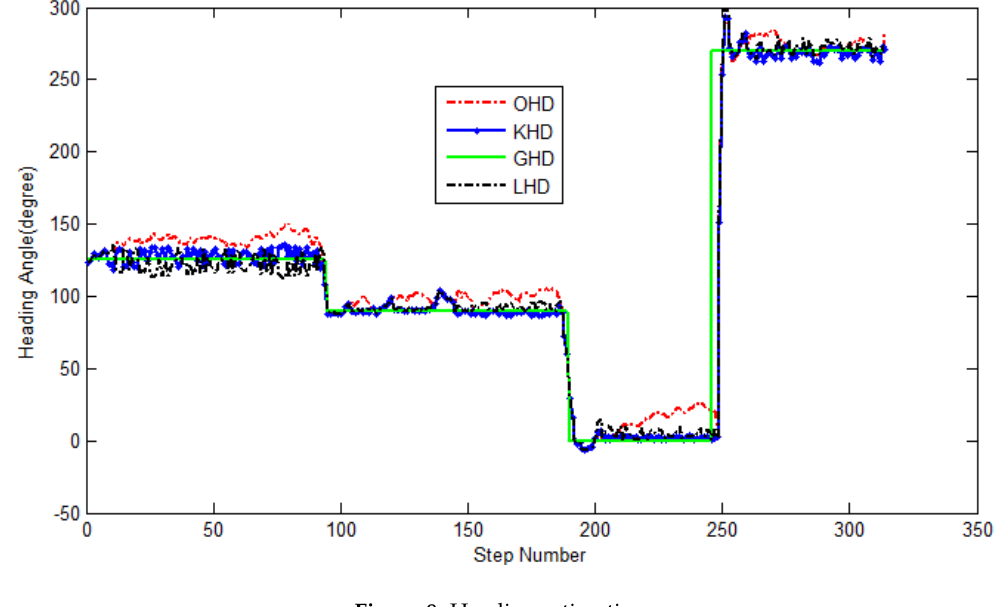
Figure 8. Heading estimation. Table 1. Comparative analysis for heading estimation error based on different methods.